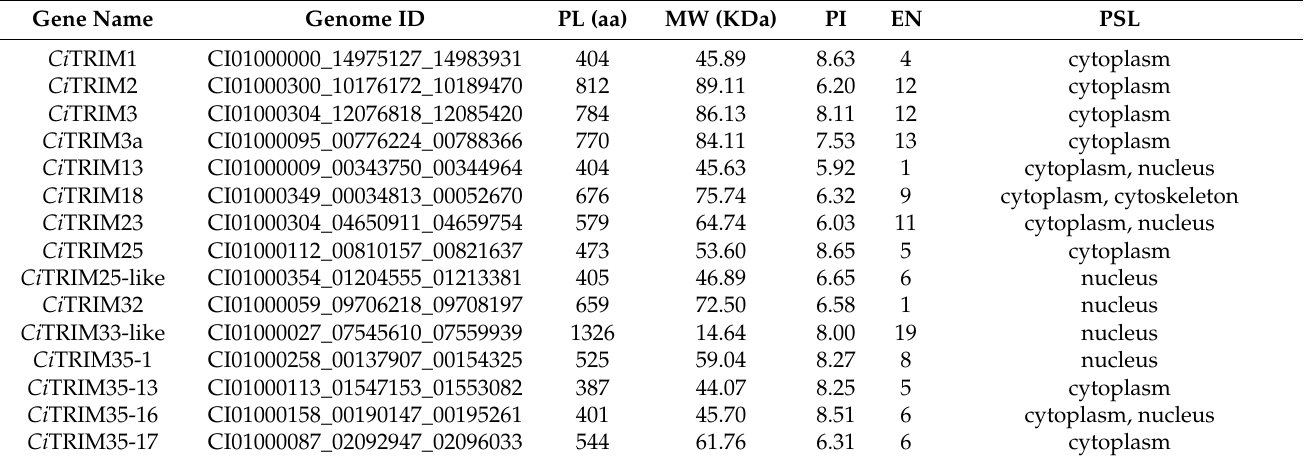
Table 2. Overall information for the 42 Ci TRIMs identified in this